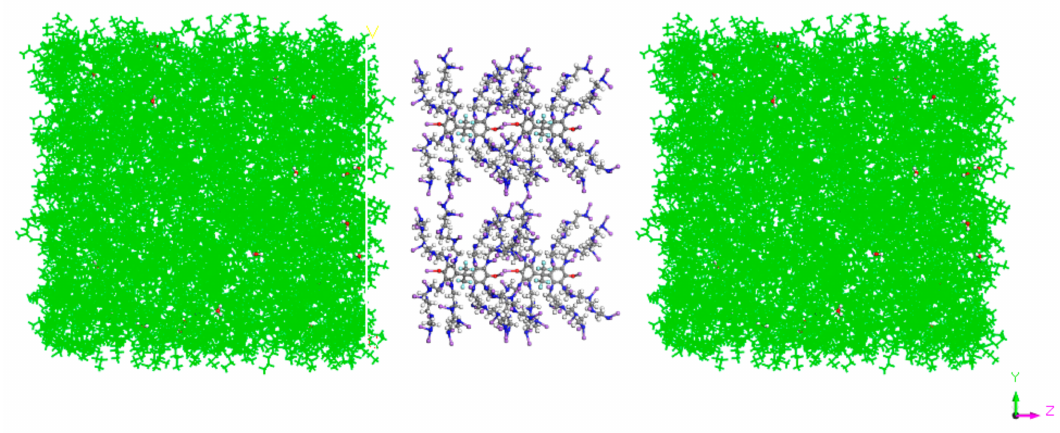
Figure 2. Demulsifier system